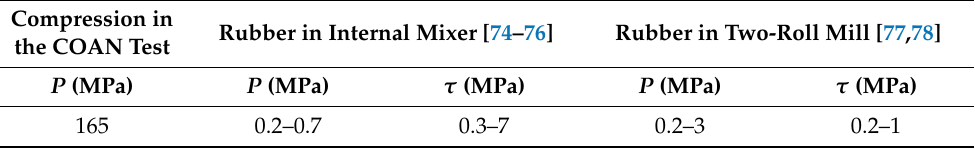
Table 5. Pressure in the COAN Test Compared to Pressures and Stresses in Rubber Processing Equipment.